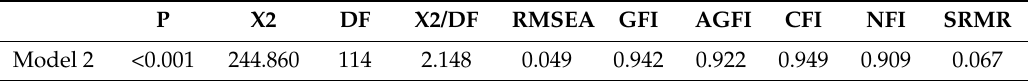
Table 3. Adjustment Rates for Model 2.